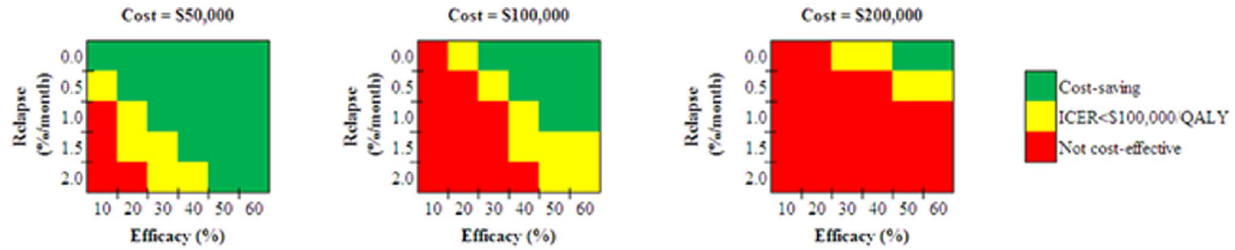
Figure 1. Gene Therapy compared to standard of care ART. The figure depicts the cost-effectiveness of Gene Therapy compared to standard of care ART as a function of the three influential parameters identified via the one-way sensitivity analysis in Table 3: cost, relapse rate, and efficacy. In each panel, the horizontal axis denotes efficacy while the vertical axis denotes the relapse rate. Inside each panel, the shading denotes the resultant cost-effectiveness finding, ranging from cost-saving (green), through cost-effective (with an ICER , $100,000/QALY, yellow), to not cost-effective ( $ $100,000/QALY or more expensive and less effective than ART, red). ART: antiretroviral therapy; ICER: incremental cost-effectiveness ration; QALY: quality-adjusted life year.